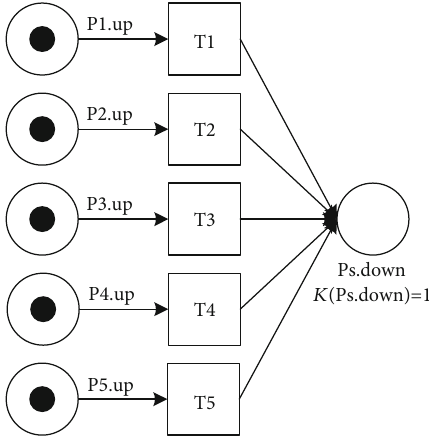
Figure 12: Petri net-based reliability model of the servo-control subsystem.